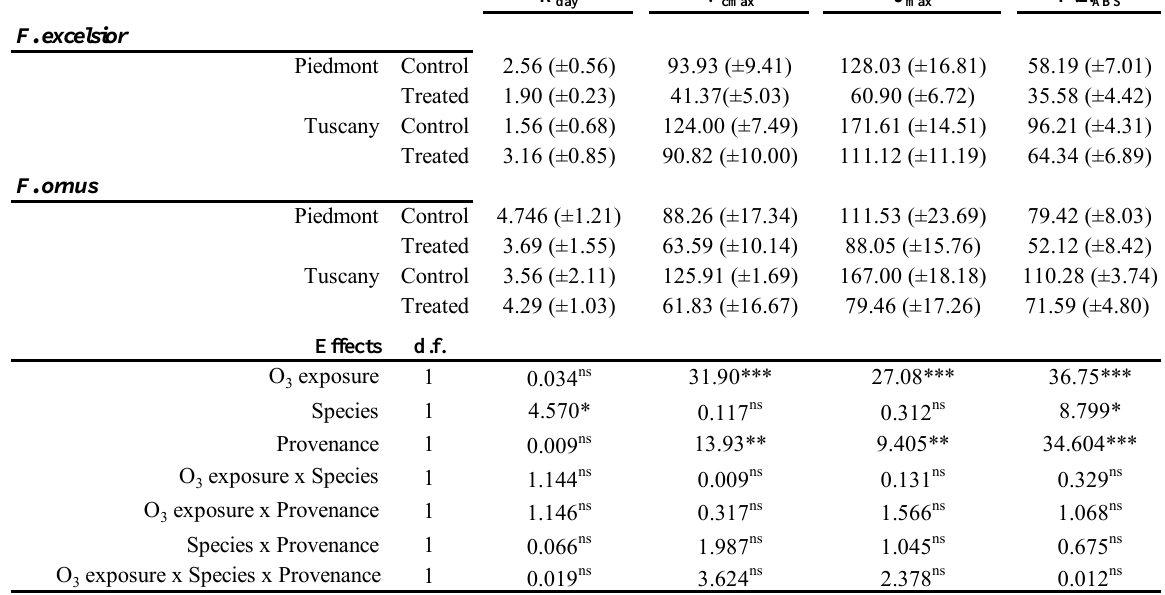
Mean Values (±S.E.) of Mitochondrial Respiration Rate in the Light (R